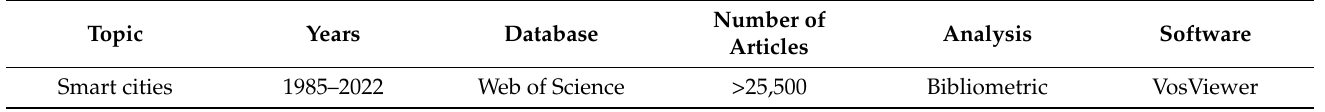
Table 1. Steps of bibliometric